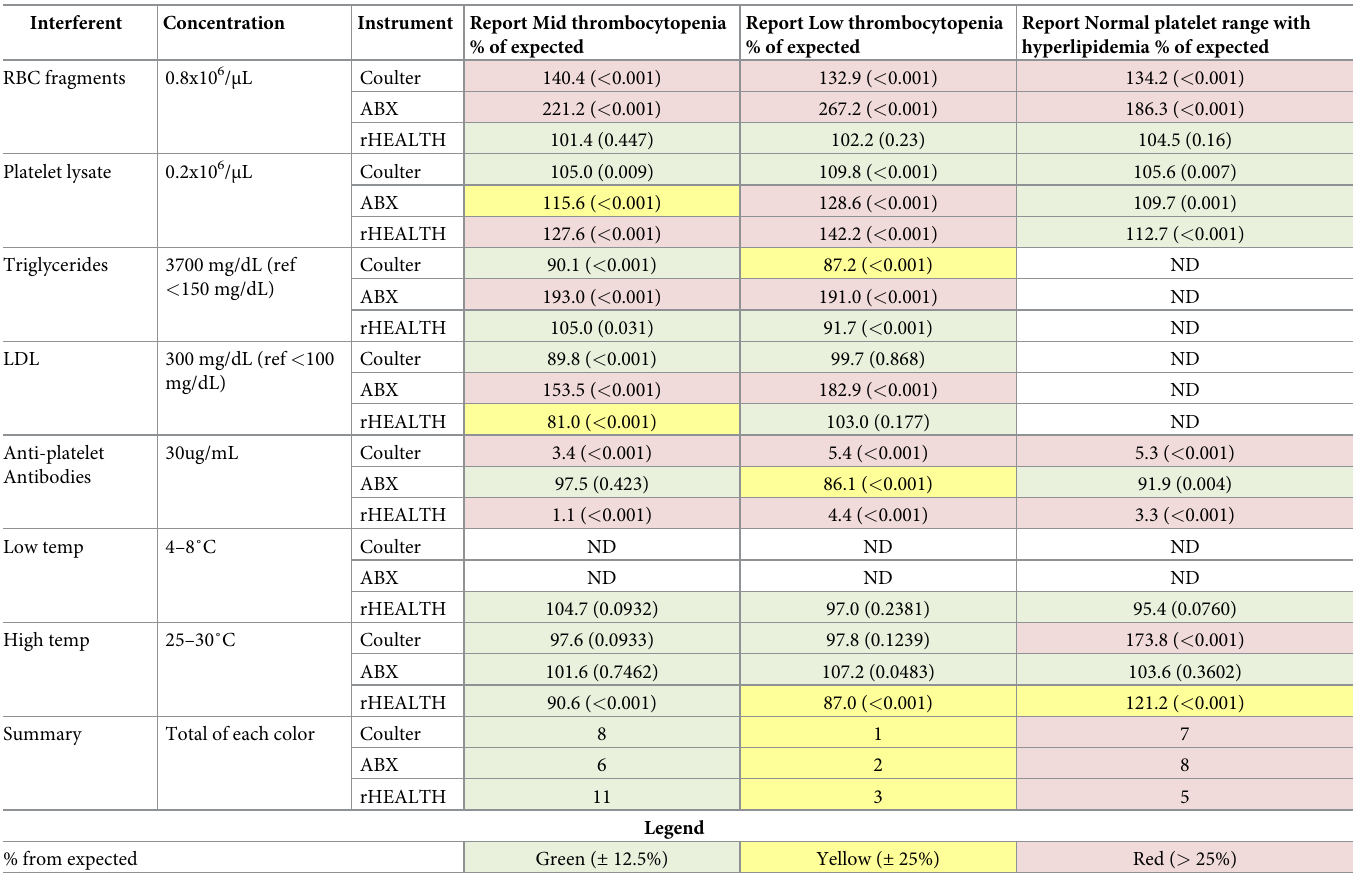
Table 1. % of expected PLT concentration with